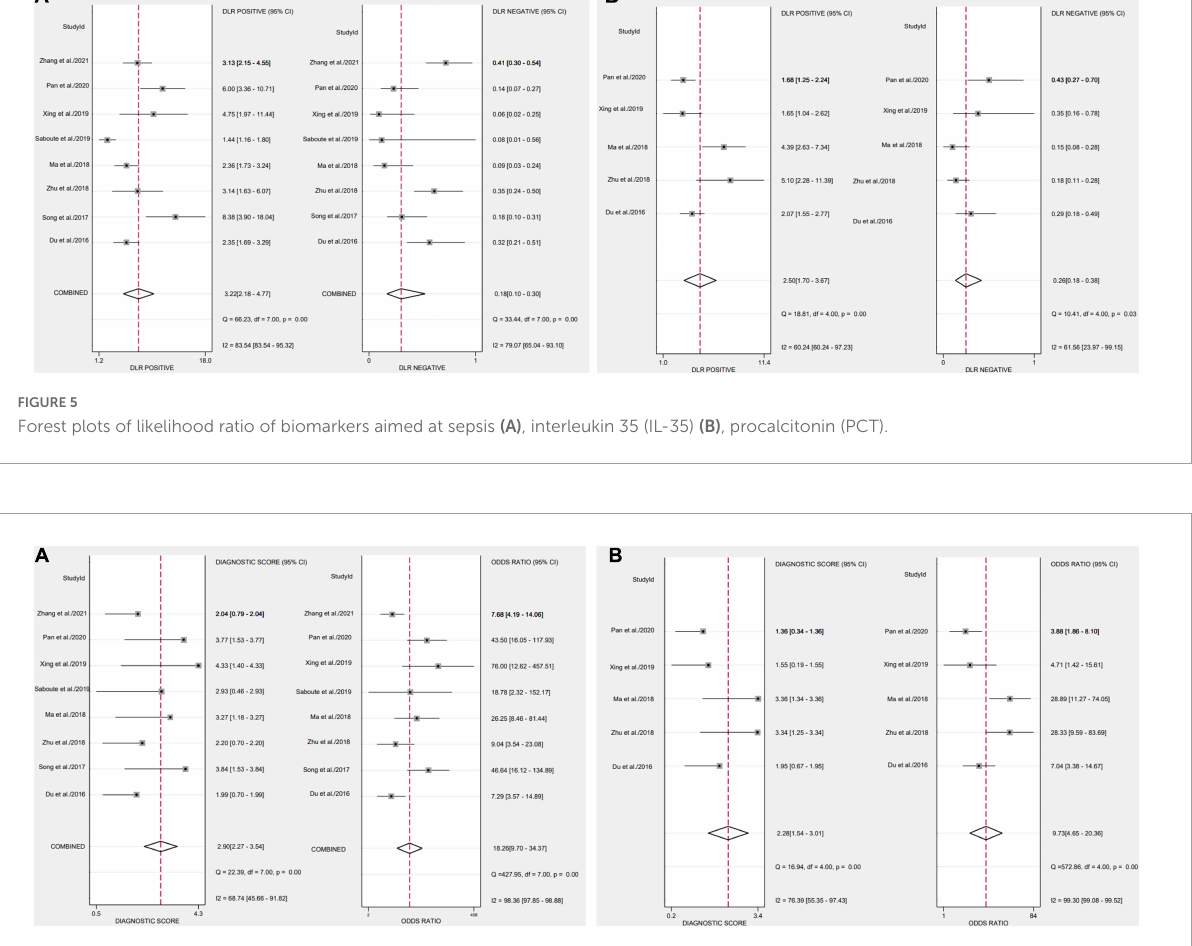
FIGURE6 Forest plots of the diagnostic odds ratio of biomarkers aimed at sepsis (A) , interleukin 35 (IL-35) (B) , procalcitonin